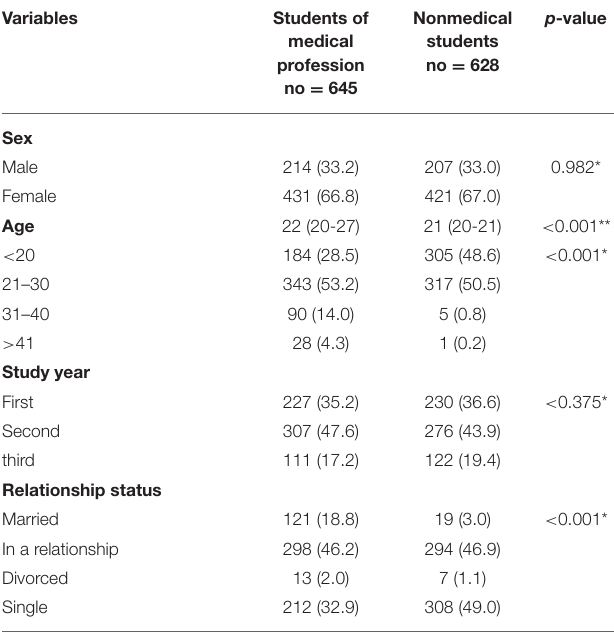
TABLE 1 | Sociodemographic characteristics of study